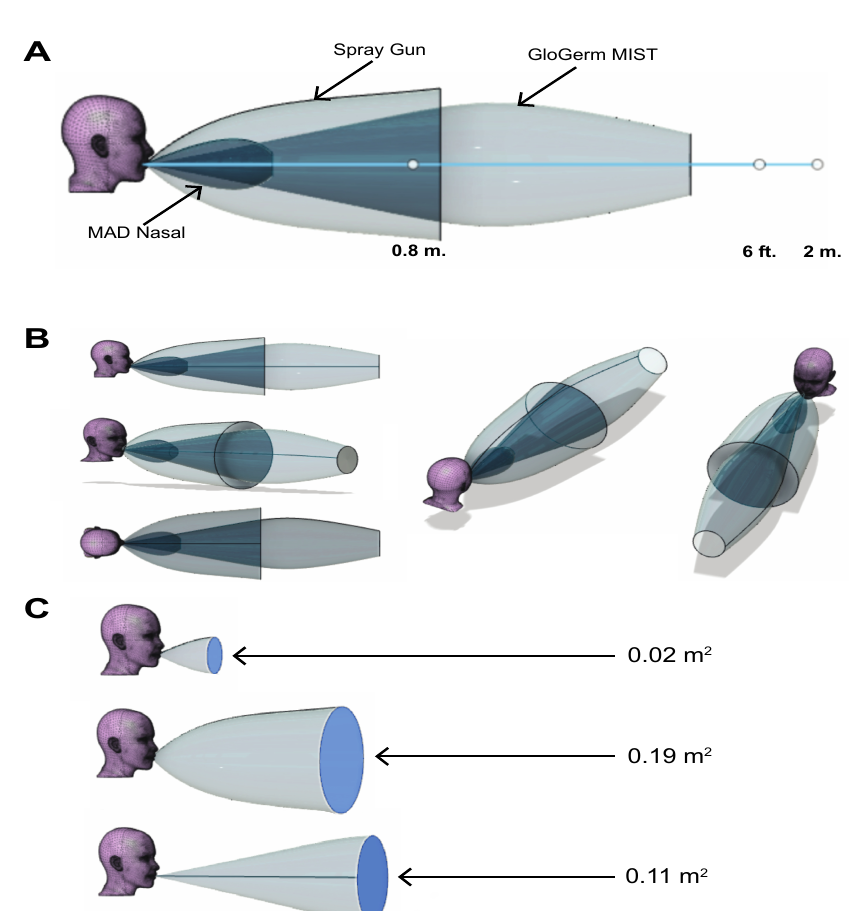
Figure 3. 3D reconstruction of simulated coughs. ( A ) A side view of all three simulated cough 3D reconstructions is shown with the relevant distances denoted by a white dot on the light blue line. ( B ) Multiple profiles of the 3D reconstructions are shown to capture visualizations from all three dimensions. ( C ) Cross sections of each reconstructed cough on Fusion 360 is shown along with the respective maximum detectable 2D projected area.